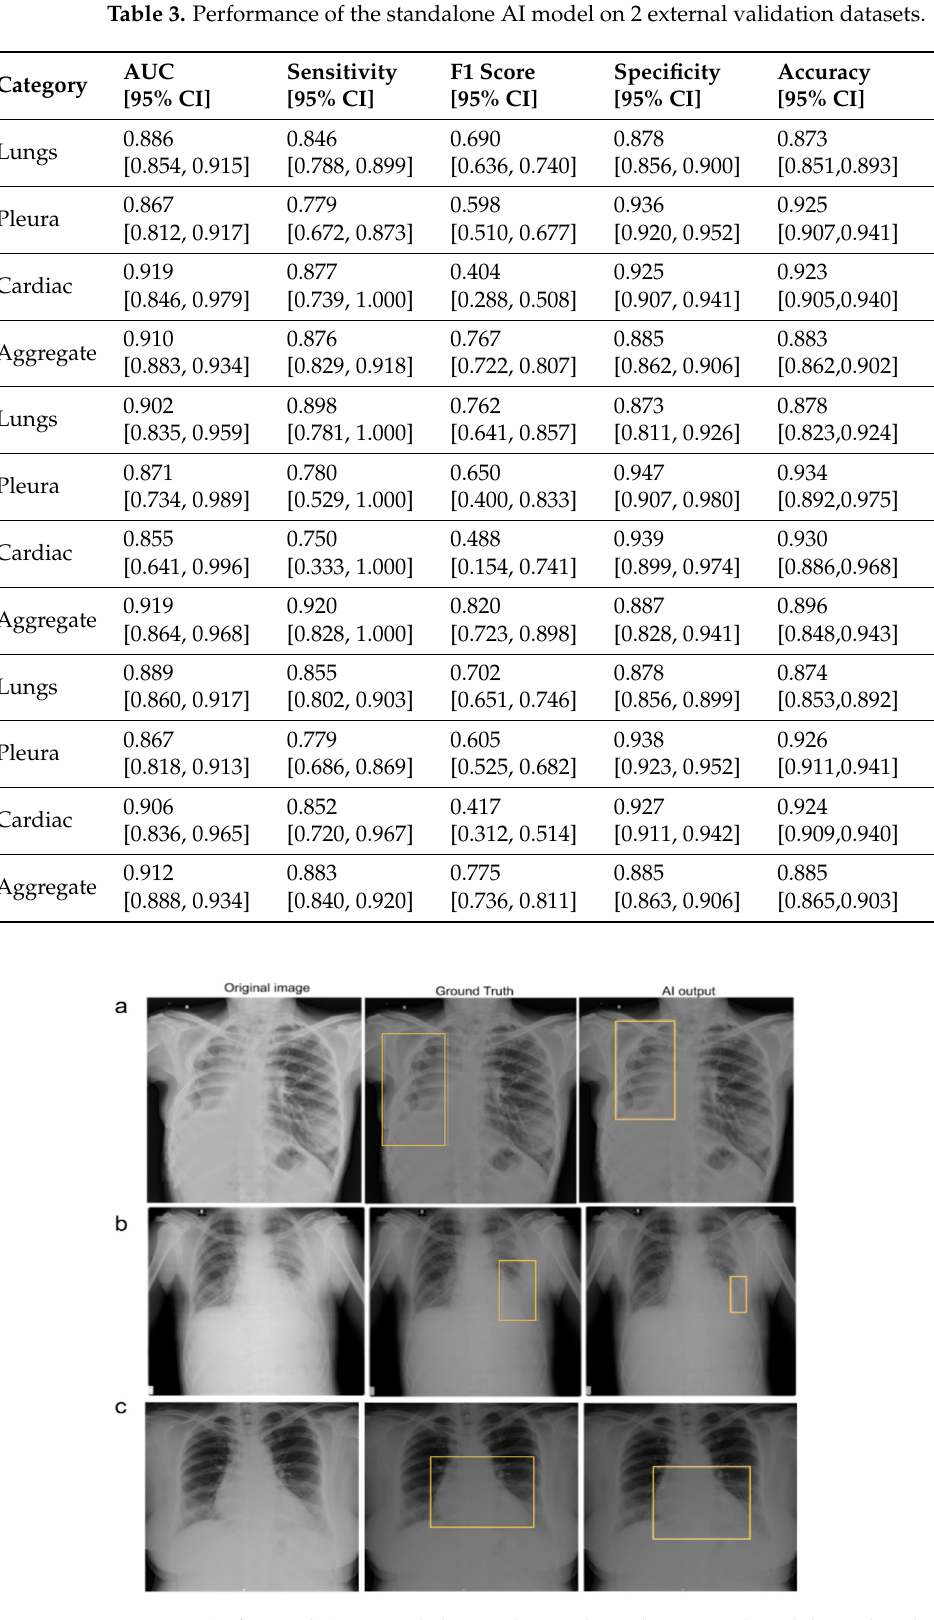
The standalone AI model had an aggregate AUROC of 91.2% and a sensitivity of 88.4% across both hospitals. In session 1 (unaided session) of the MRMC study, the aggre ‐ gate AUROC and sensitivity for human readers across both hospitals were 84.2% and 74.5%, respectively. The aggregate AUROC and sensitivity of the AI model were signifi ‐ cantly higher (** p < 0.01) than the aggregate sensitivity and specificity of all 3 readers across the two hospital datasets. However, the aggregate specificity of the model was lower than the specificity of the human readers. 3.4. Comparison between Human Readers in Unaided and Aided Sessions In session 2 of the MRMC study, the aggregate AUROC of test readers improved from 84.2% in the unaided session to 87.9% in the aided session across both hospitals. AI assistance significantly improved the aggregate sensitivity of test readers from 74.5% to 85.1% across both hospitals. While there was a significant improvement (** p < 0.01) in the aggregate AUROC and sensitivity of all three readers across different hospitals, there was no significant improvement in aggregate specificity values, as they remained consistently high for the readers in both sessions. Table 4 compares the AUROC, sensitivity, and spec ‐ ificity of the unaided and aided readers in the individual hospital datasets. The aggregate performances of the unaided and aided readers (RI, R2, and R3) across all categories and hospital datasets are tabulated in Supplementary Materials Table S1. The aggregate sensitivity and specificity of different readers (R1, R2, and R3) in unaided and aided reading sessions, using the consensus of three board ‐ certified radiologists as a ground truth reference standard, are shown in Figure 5.